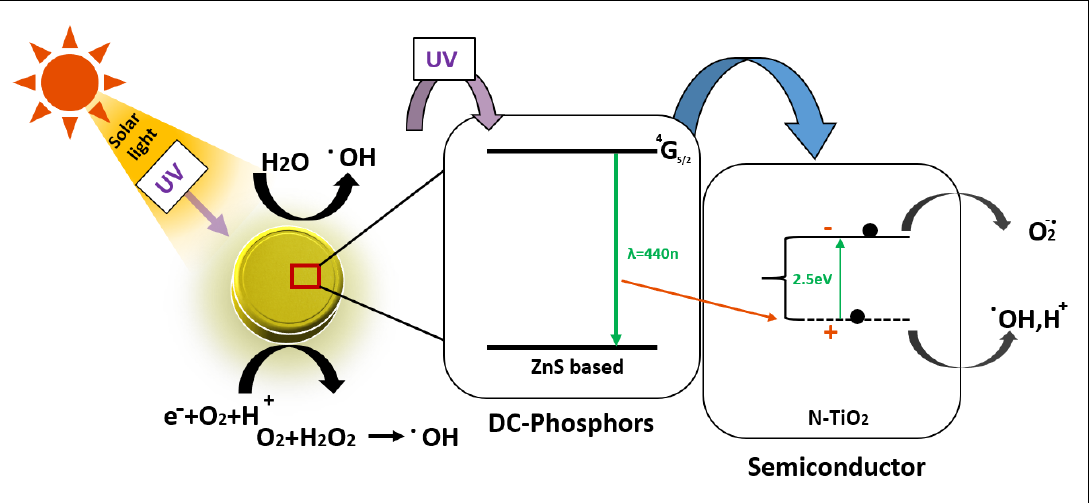
Figure 3. The down-conversion phosphor way of action. Adapted with permission from [53]. Copyright 2015 Elsevier.